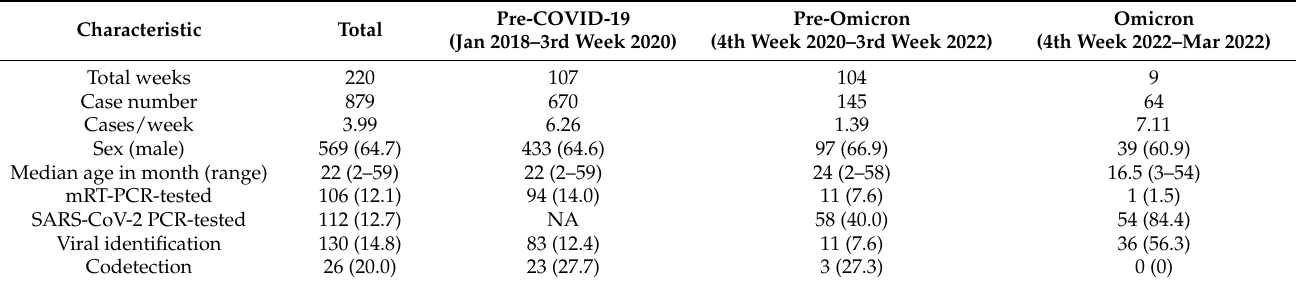
Table 1. Demographics of children diagnosed with croup during 2018–2022, South Korea.